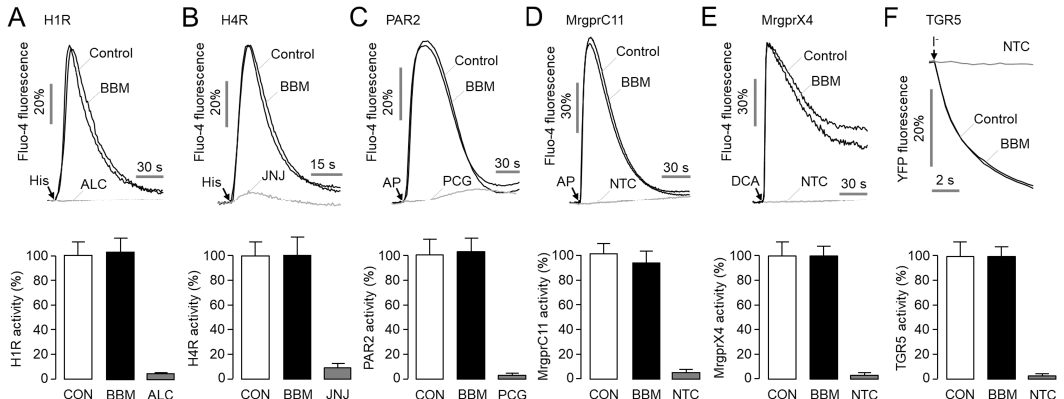
did not alter any of the agonist-induced activation of H1R, H4R, MrgprC11, MrgprX4, PAR2, or TGR5.